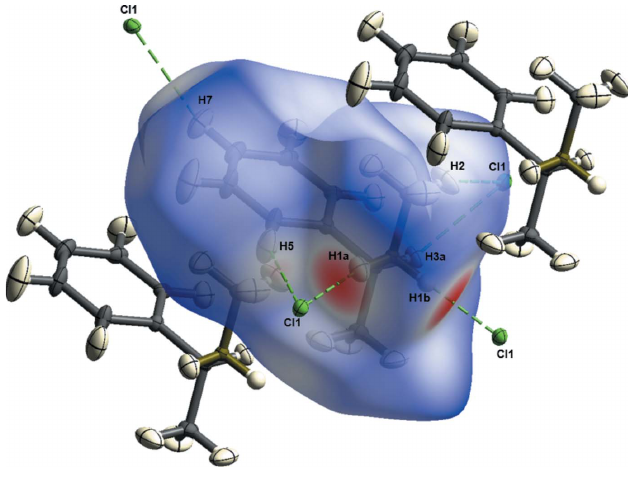
Figure 3 Hirshfeld surface of compound 1 generated by CrystalExplorer21